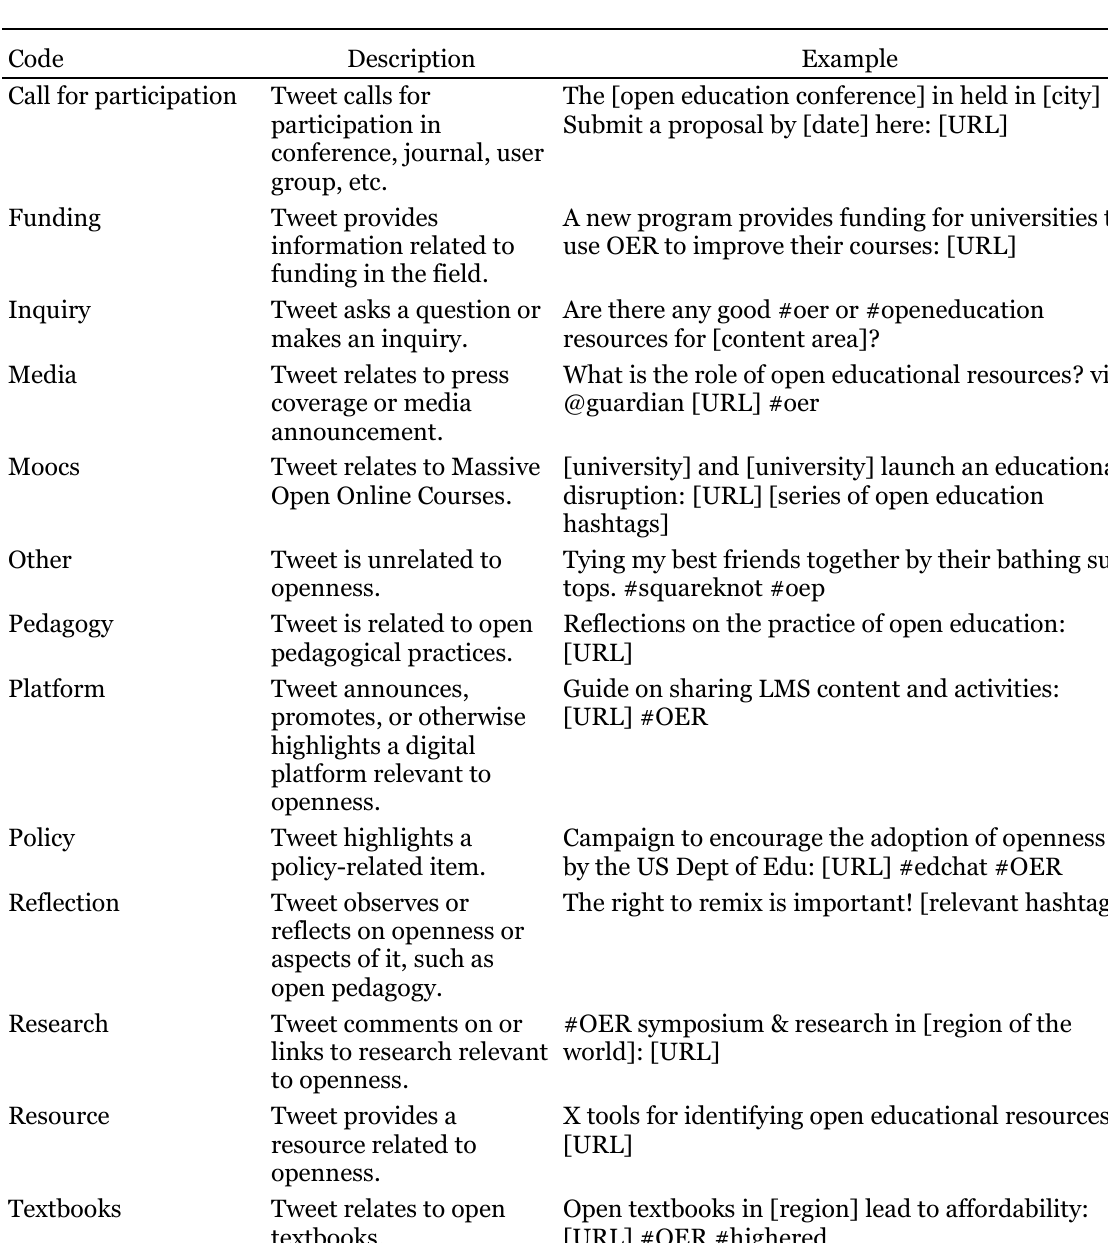
Sample of Coding as Applied to